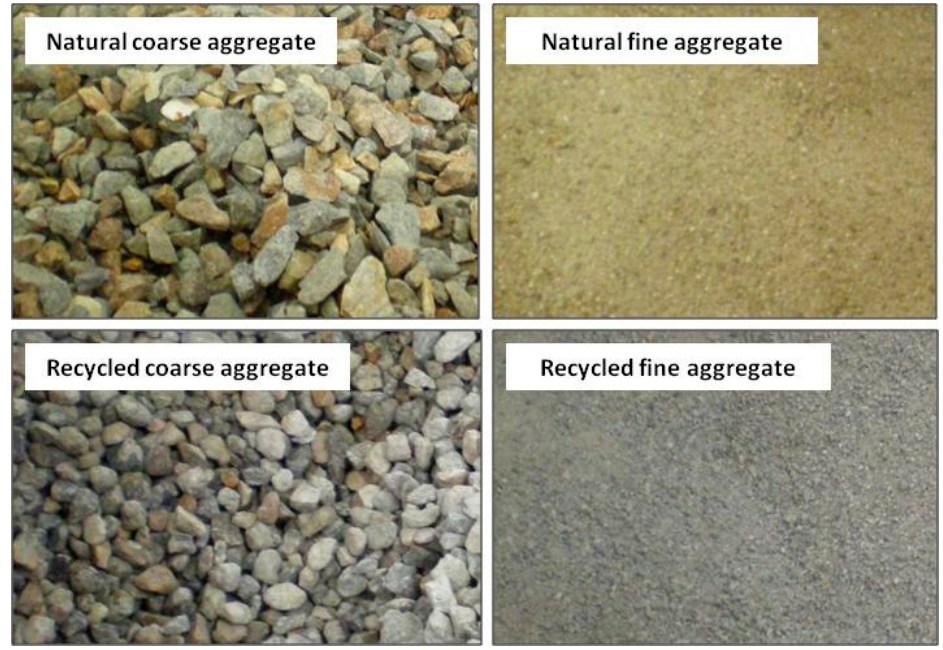
Figure 1. Aggregates used in the experimental work.